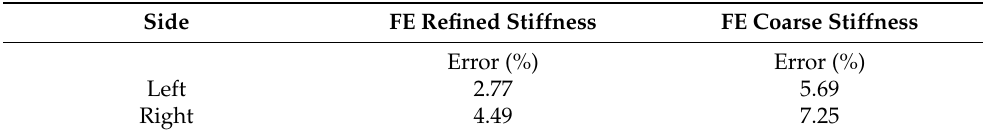
Figure 9. Comparison between the FE moment-angle curve and the corresponding experimental curve obtained considering the torque measure on the right shaft (R) and the left shaft (L) for the differential torsion test. Table 3. Comparison of the errors between experimental and numerical torsional stiffness values for the two FE models (finer and coarser).